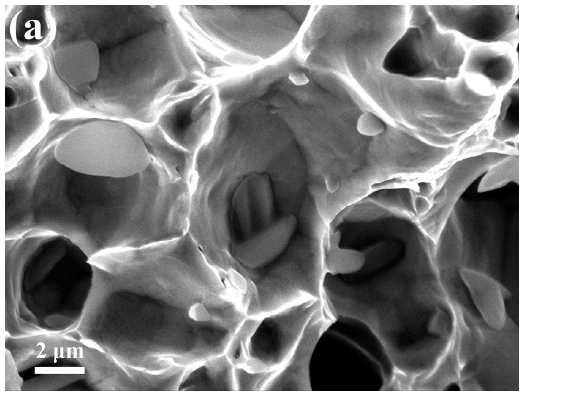
Figure 15. EDS analysis of a second phase in fracture of 1280-S3 ODS steels. 4. Conclusions The nucleation mechanism of Y-O-Si nanoclusters in the bcc Fe matrix were ex- pounded through first-principles calculations. Additionally, those containing Si ODS steels were synthesized through an MA and vacuum sintering process. The specific re- search results are summarized as followed: • The solutes Y and Si preferred substitutional site, while O preferred octahedral inter- stitial site. The binding sequence of solutes with v followed O- v > Y- v > Si- v , and the affinity of Y, Si and v with O followed O-Y >O- v >O-Si. The most stable Y-O-Si nanocluster ( E b = − 2.60 eV) of 10 di ff erent structures were generated preferentially. The nucleation mechanism of non-stoichiometric Y-O-Si nanoclusters determined